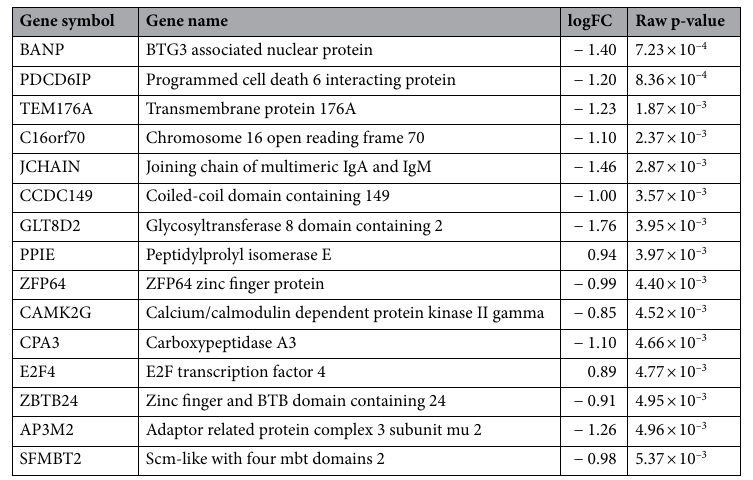
Table 2. Top fifteen most differentially expressed mRNAs from the Genome-Wide Transcriptome study. logFC log fold change.